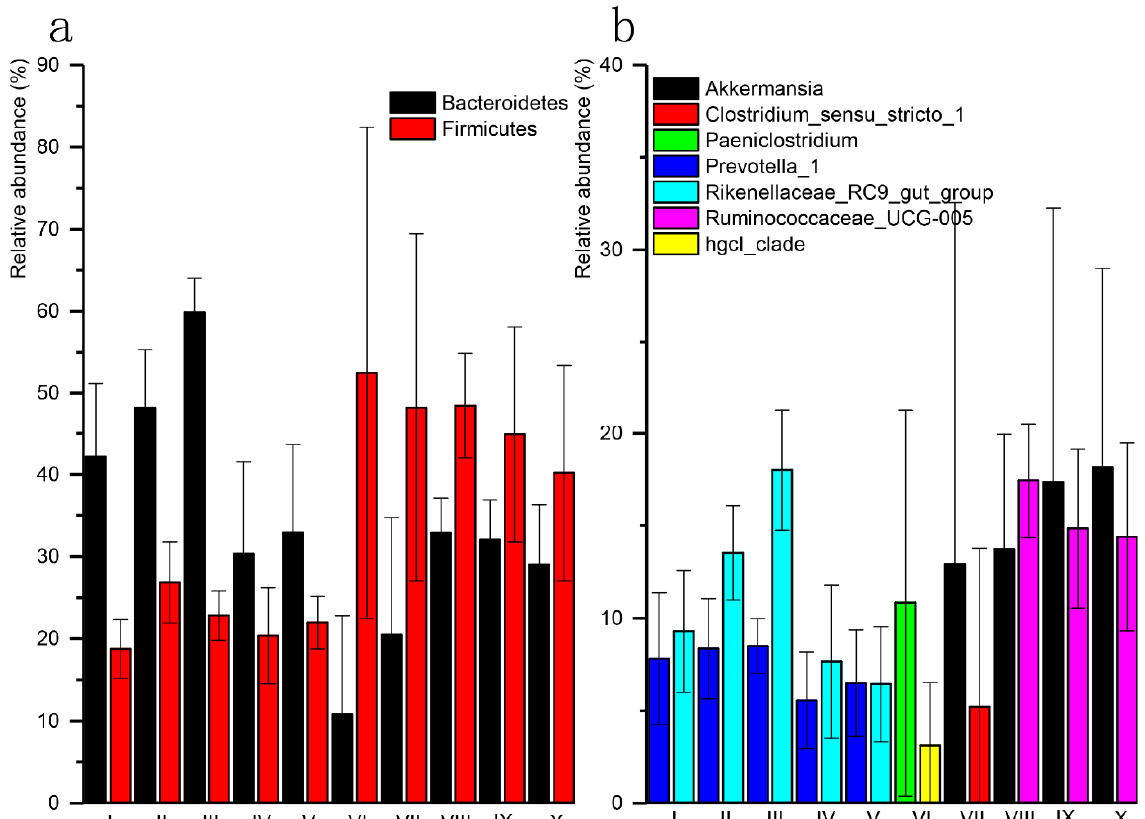
Figure 3. Bar plot shows the most abundant two phylum ( a ) and genus ( b ) based on relative abundance in 10 sections: rumen (I), reticulum (II), omasum (III), abomasum (IV), duodenum (V), jejunum (VI), ileum (VII), caecum (VIII), colon (IX) and rectum (X) in the GIT of yaks.